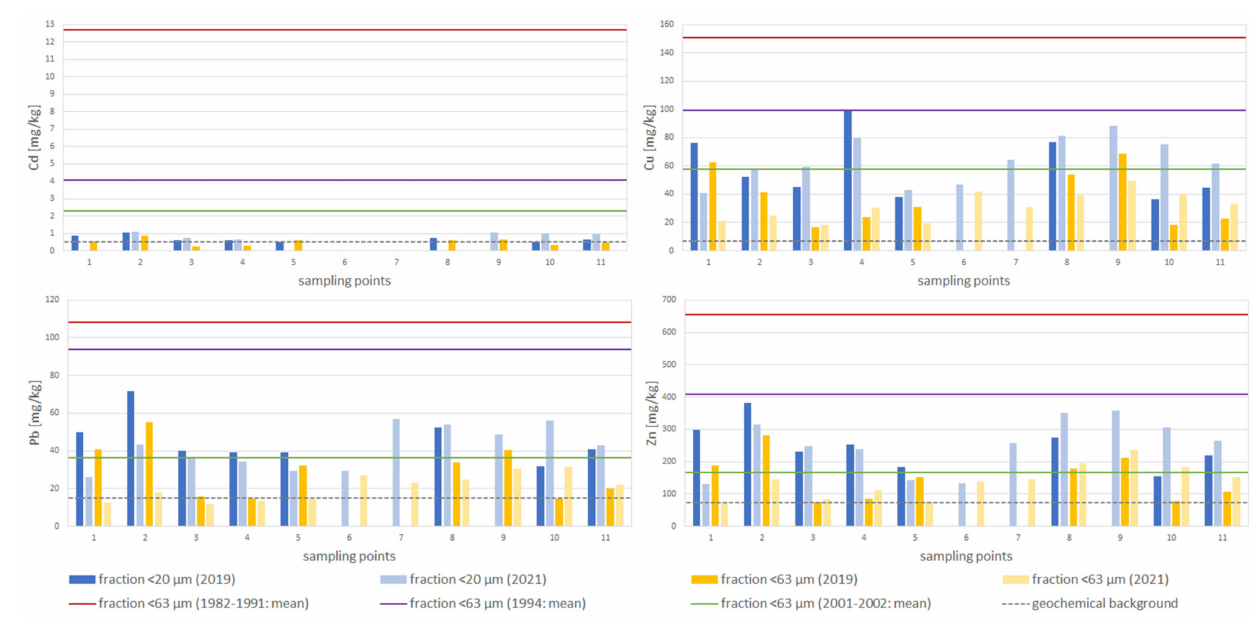
Figure 4. Comparison of selected metal concentrations (Cd, Cu, Pb and Zn) in Wilga River bottom sediments (fraction <20 µ m and <63 µ m; 2019 and 2021) with geochemical background [87] and with data from previous studies: mean concentrations in fraction <63 µ m from two sampling campaigns (1982–1991 and 1994), according to [56] and mean concentrations in fraction <63 µ m from sampling campaign 2001–2002, according to [57].